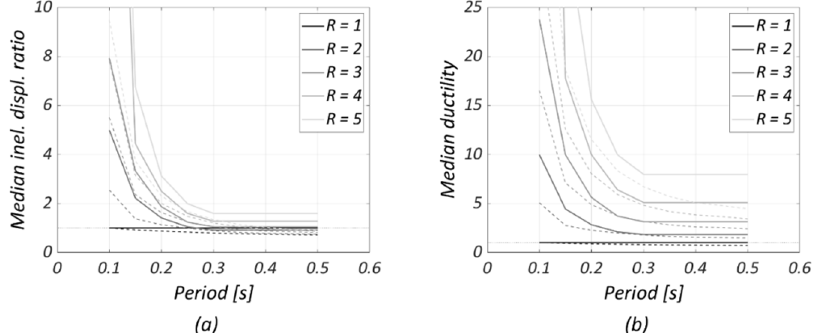
Figure 4. Comparison between the predictions by the CSM of NPR 9998-18 (solid lines) and the results from NLTHA of Suite 2-A (dashed lines): ( a ) median C R − R − T curves, and ( b ) median µ R − R − T